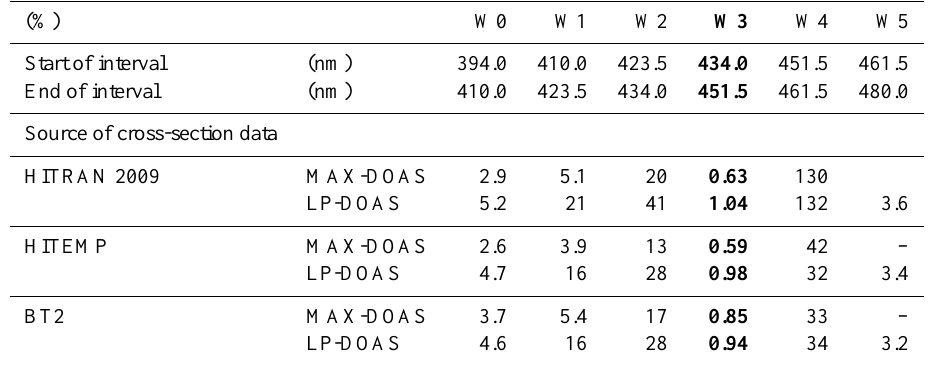
Table 6. Typical relative DOAS fit errors in fitting windows W0–W5 at a water vapour dSCD in W3 (bold) of 4 × 10 23 moleccm − 2 for an individual spectrum integrated over 60s (MAX-DOAS) and 280s (averaged, LP-DOAS). Values are given in percent and are corrected by the relative sizes given in Table 5. For all weak absorption bands W1, W2 and W4 a reduction of fit errors is observed from HITRAN 2009 to HITEMP or